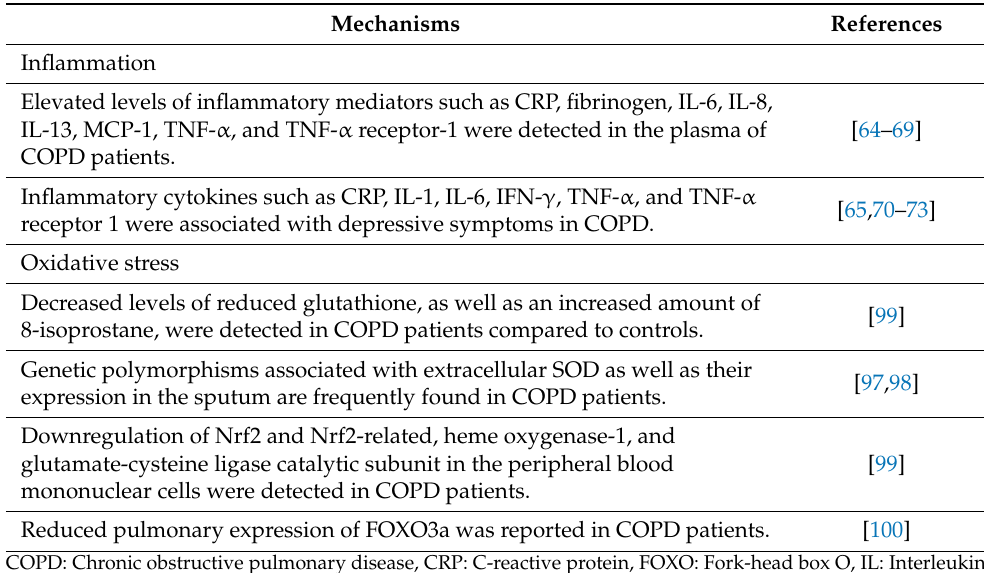
Table 2. Shared mechanisms between COPD and mood